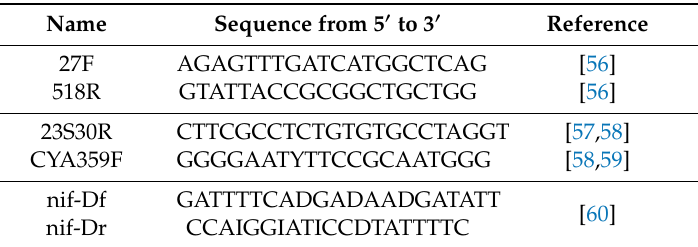
Table A2. Primer sequences used for